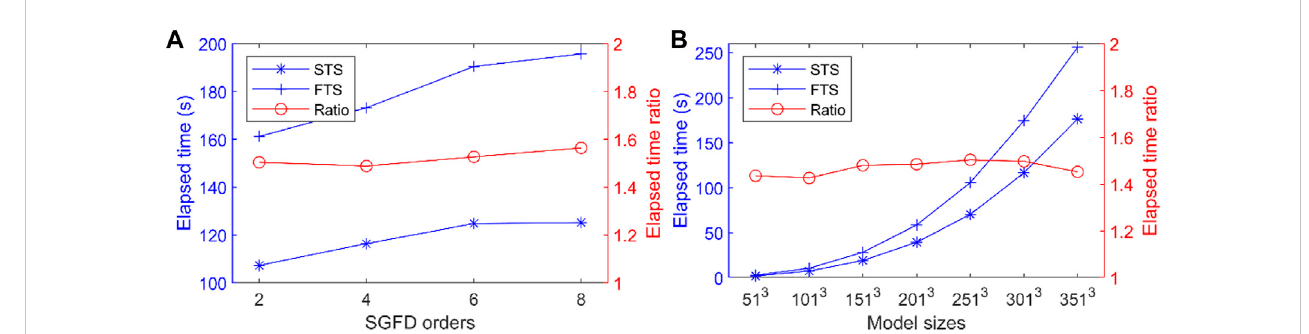
FIGURE 10 Ef fi ciency comparisons oftheSTS andFTS method (A) with theincreaseofSGFD orders and (B) with theincrease ofmodelsizes. The model size is301× 301×301in (A) ,andthefourth-orderspatialaccuracyisusedin (B) .In (A) and (B) ,theleftaxisrepresentsthetimeconsumptionandtherightaxisrepresentsthe time consumption ratio of FTS to STS.